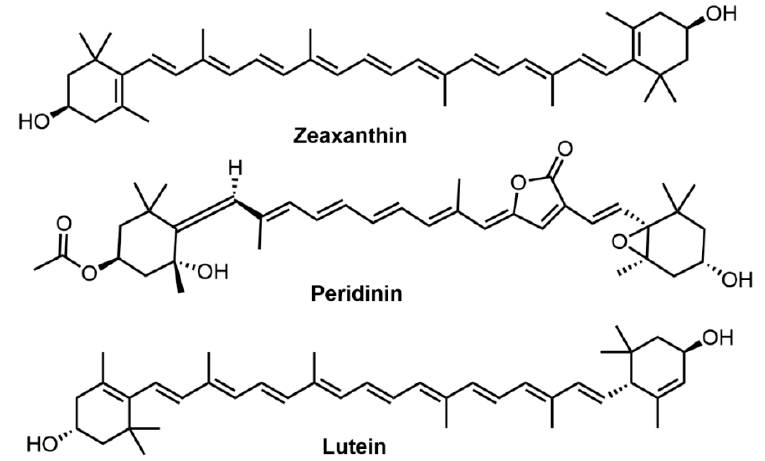
Figure 7. Molecular structures of zeaxanthin, peridinin, and lutein.